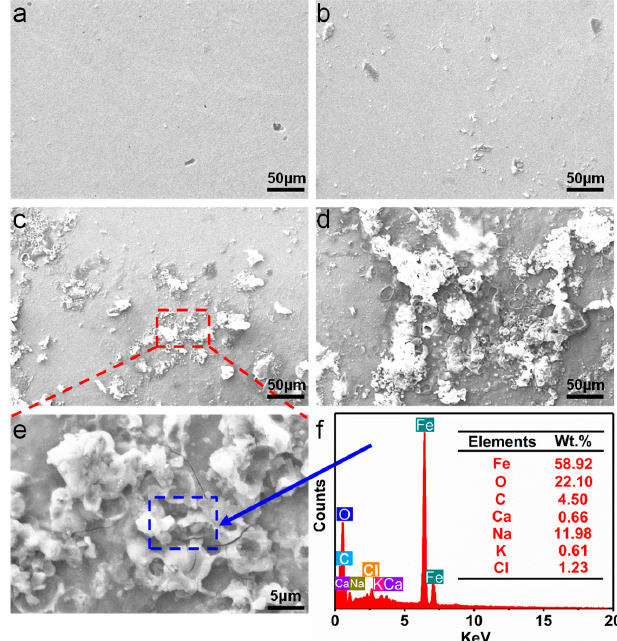
Figure 6. Surface of ( a ) Fe, ( b ) Fe / 0.5MC, ( c ) Fe / 1.0MC and ( d ) Fe / 1.5MC after polarization tests; ( e ) Locally enlarged image of Fe / 1.0MC and ( f ) energy dispersive spectrometer (EDS) analysis of the marked area in Figure 6e. Appl. Sci. 2020 , 10 , x FOR PEER REVIEW